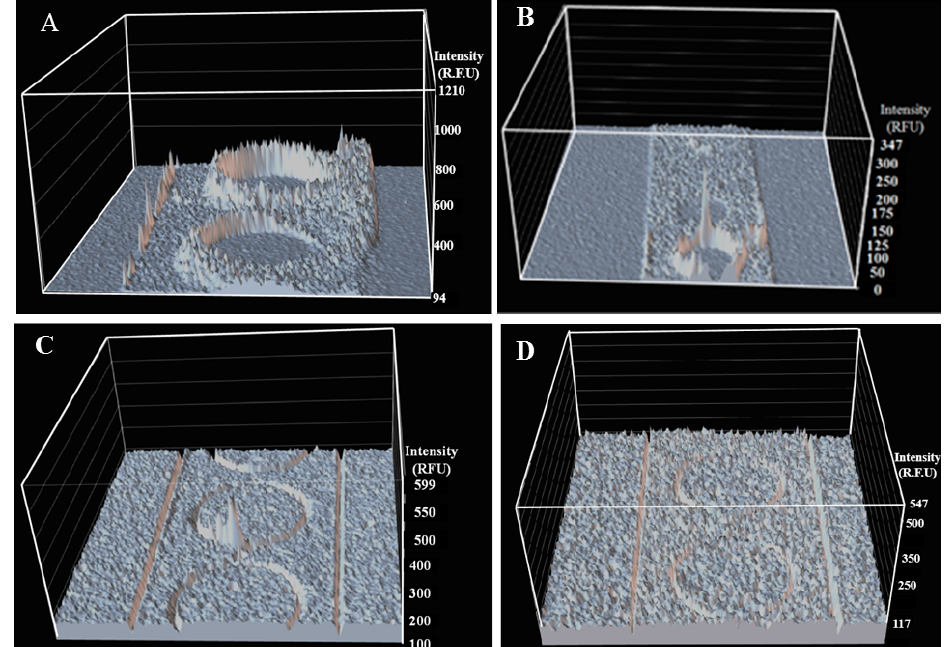
Figure 4. An analysis of P. aeruginosa PAO1 biofilm with two different antimicrobial agents. ( A ) 20% ethanol solution with a 30-min mixing time; ( B ) 90% ethanol solution with a 7-min mixing time; ( C ) 1-TDPPO with a 5-min mixing time; and ( D ) 1-TDPPO with a 7-min mixing time. Table 1. Summary of fluorescence intensity (RFU) with antimicrobial